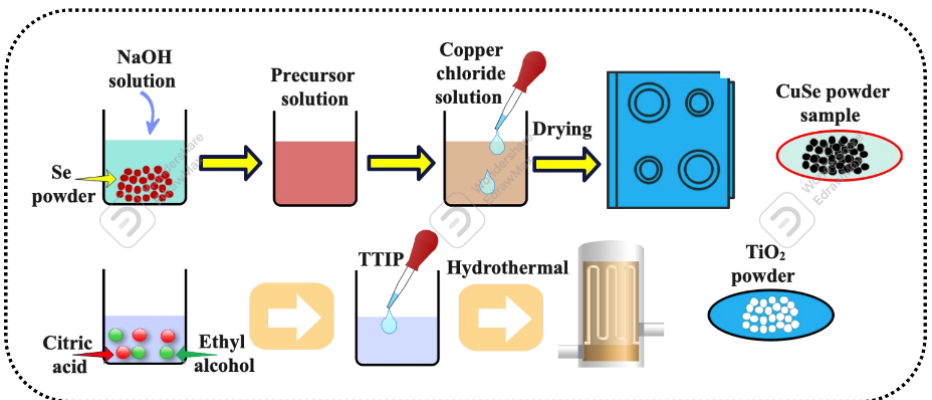
Figure 2. Illustration of the synthesis of the CuSe-TiO 2 matrix.